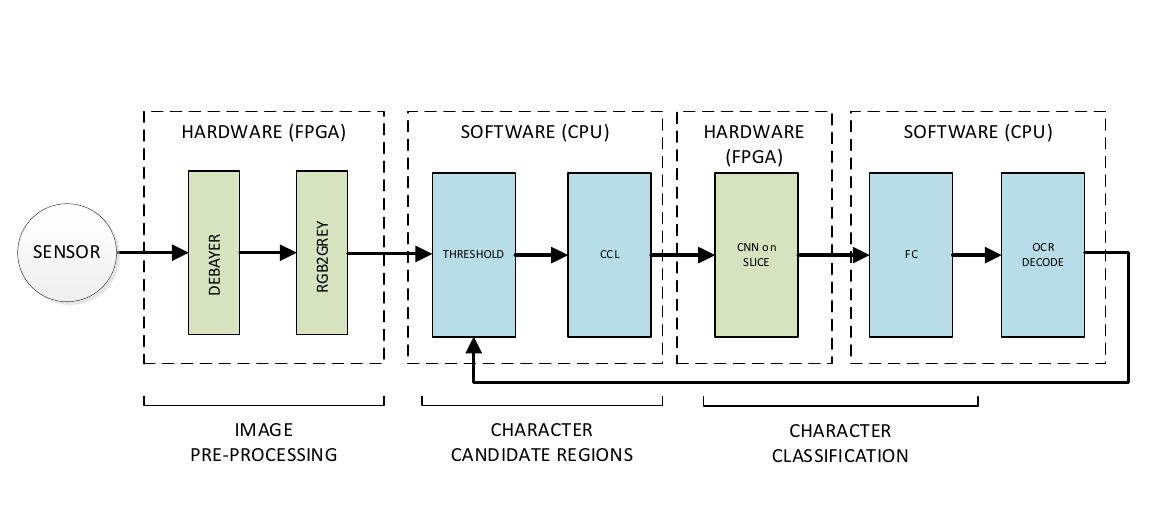
Figure 2. Industrial Setup for fast OCR